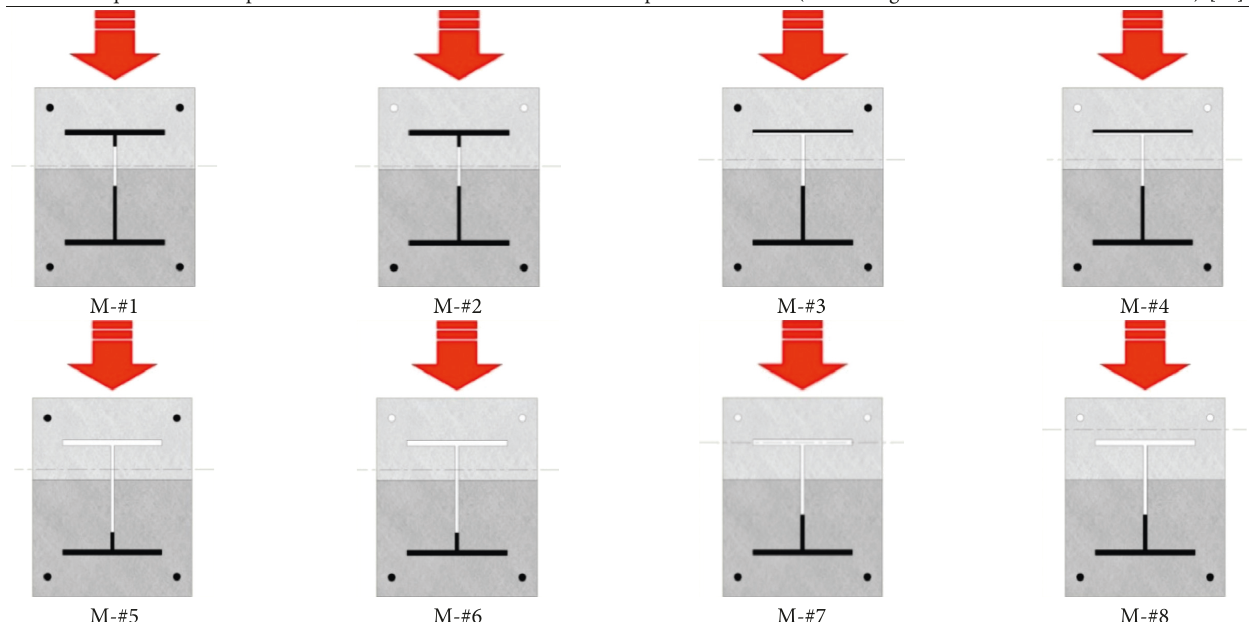
Table 3: Equilibria of all possible stress states for steel-concrete composite members (wide flange steel and maximum load state)